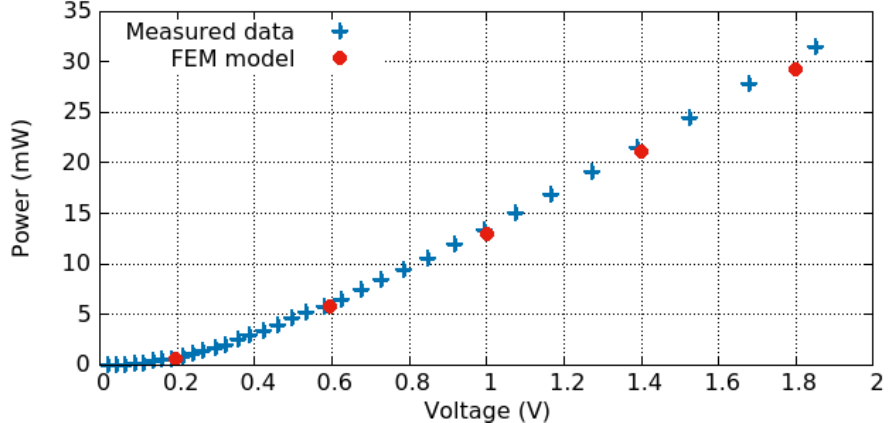
Figure 9. FEM simulation and measured power dissipated by the sensor for different applied biases.